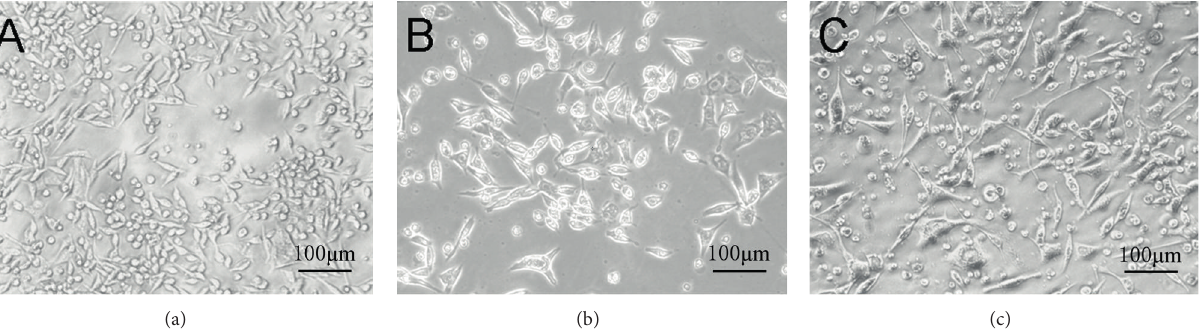
Figure 3: Inductive effect of sodium valproate on TFK-1 cell differentiation. Dendrite-like structure formation in TFK-1 cells treated for 120h with (a) 0 mM (control), (b) 0.5 mM, and (c) 2mM sodium valproate. With the increase of sodium valproate concentration, the dendrite-like structures became progressively longer. The morphology of cells was analyzed using a Nikon FX-35A camera (200x magnification). Each experiment was performed in triplicate.